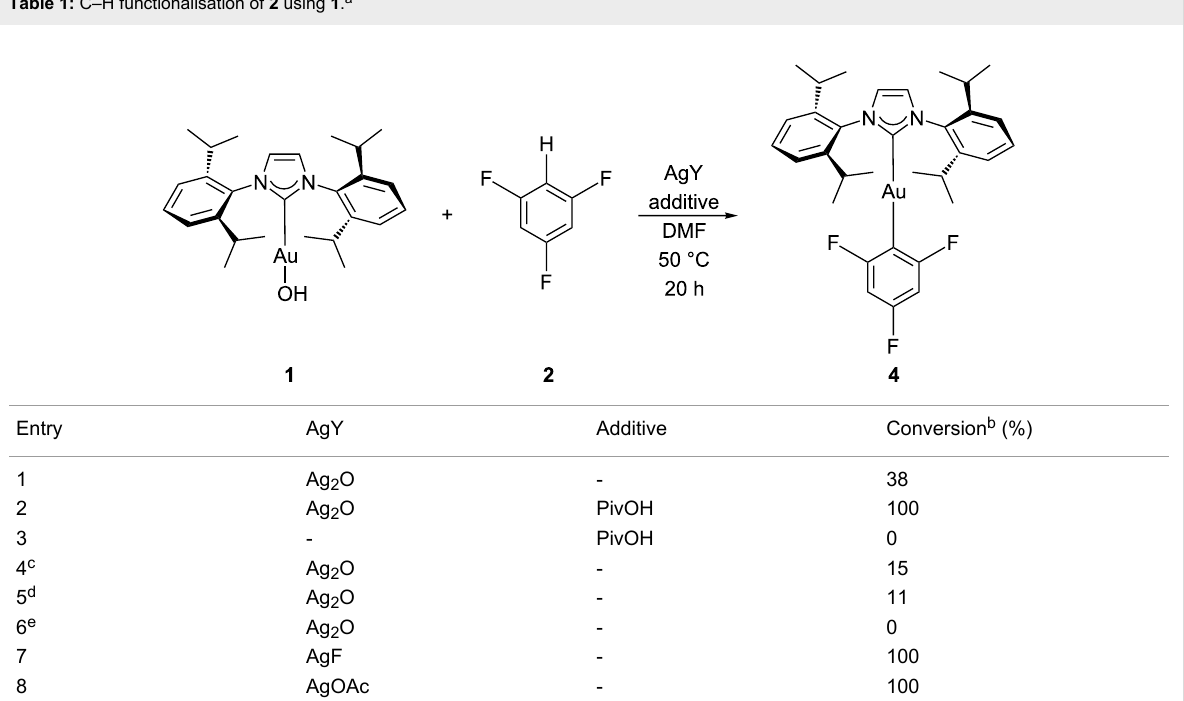
Table 1: C–H functionalisation of 2 using 1 . a